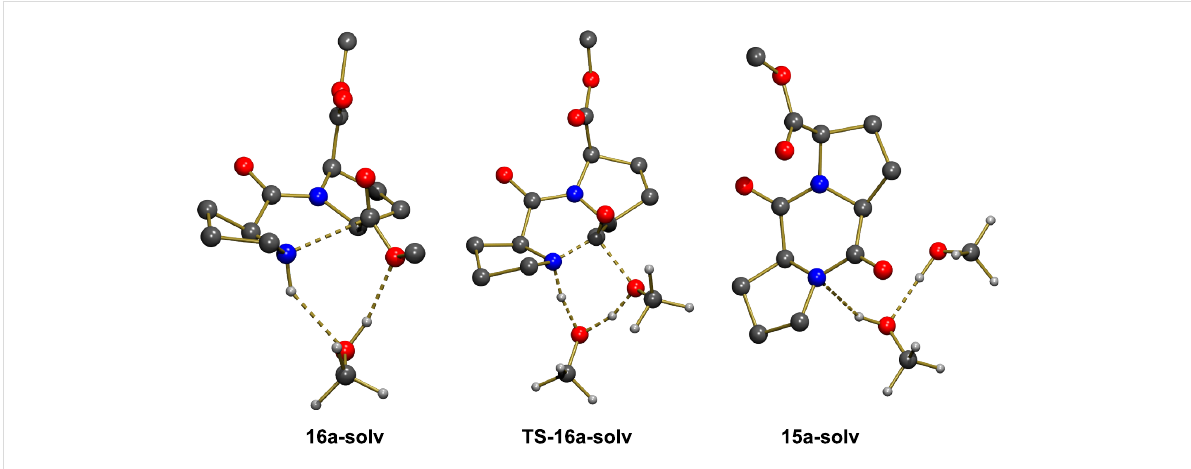
Figure 2: Optimized geometries of the extrema located along the pathway for formation of 15a with explicit participation of one solvent molecule. Most H atoms were omitted for clarity.